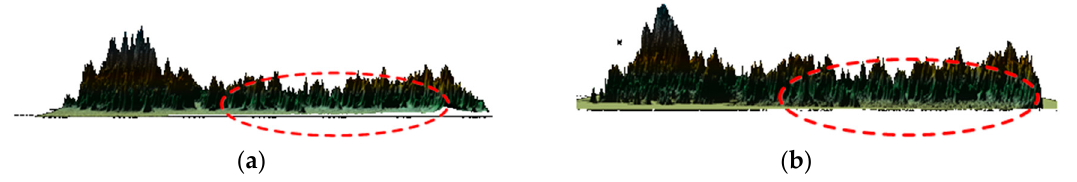
Figure 12. DEM product after correcting ∆ B (cid:107) for the second time: ( a ) SRTM DEM; ( b ) GF-3 generated DEM.